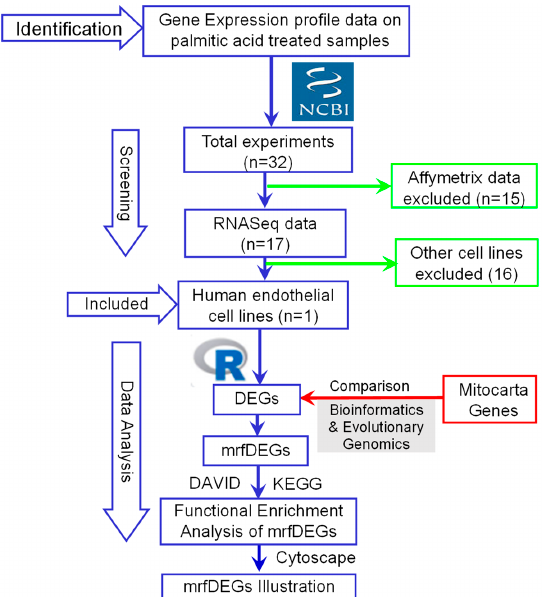
Figure 1. A flowchart describing the procedures used for the identification, selection, screening and analysis of data. DEGs: differentially expressed genes, mrfDEGs: mitochondrial-related functional DEGs, NCBI: National Center for Biotechnology Information.